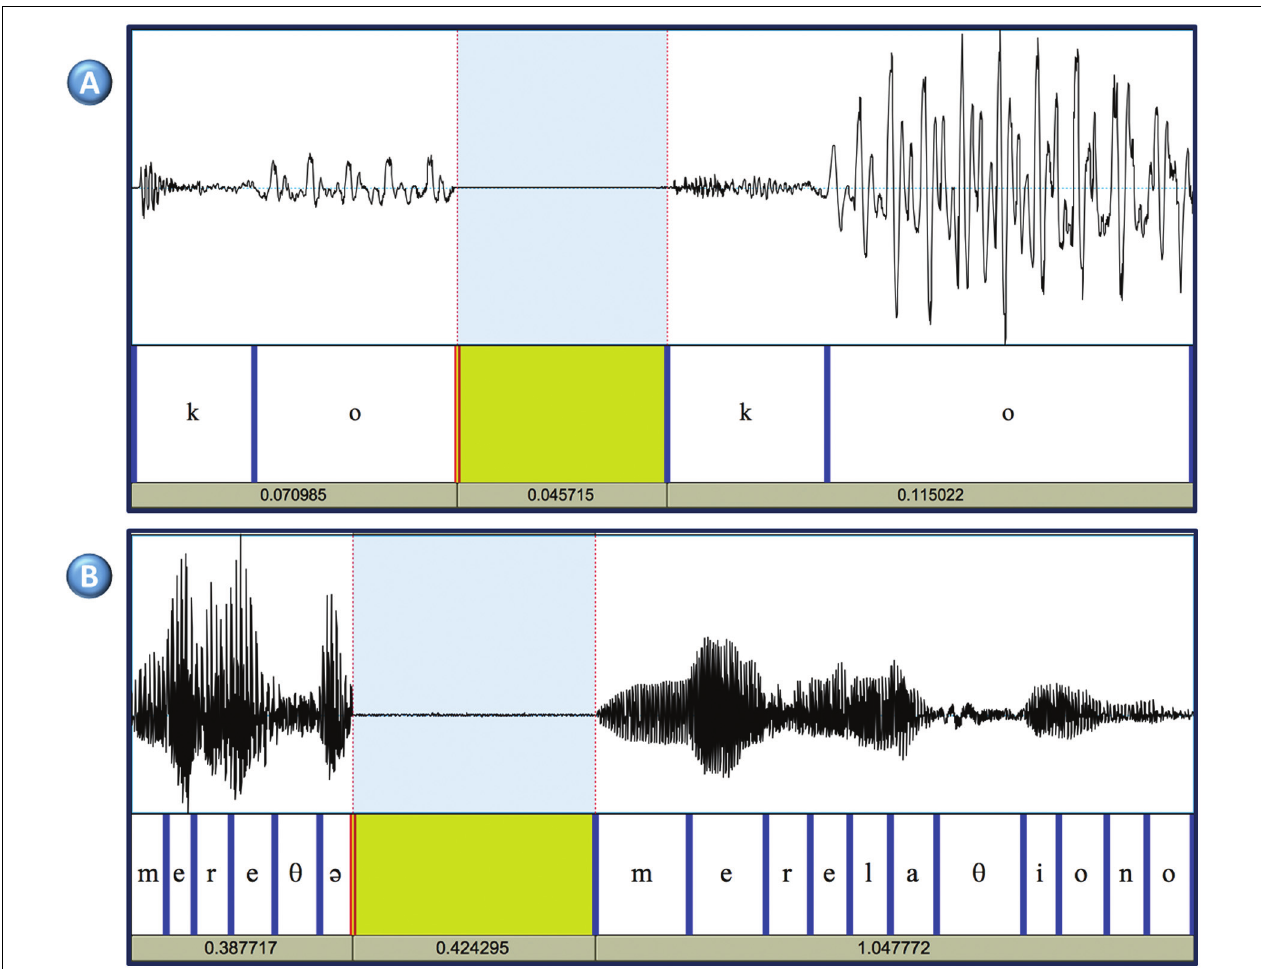
FIGURE 1 | (A) Consonant strengthening (or vowel weakening) Syllable /ko/ produced by subject 1 (left) and a control subject (right). The amplitude of the signal in the VOT interval is almost identical in the two subjects (46–47 dB), but the vowel is produced with more energy by the control subject (peak intensity: 52 dB